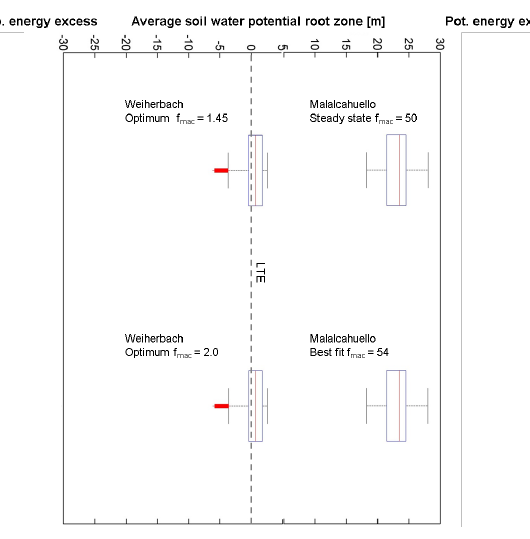
Fig. 13. Box plots of the soil water potentials for the two optima for the Weiherbach as well as steady-state macroporosity and the best fit model structure of the Malalcahuello catchment averaged across the top 1 meter of the soil (this corresponds to rooting depth in the Weiherbach and to one third of the rooting depth in Malalcahuello). Average soil water potentials are 0.49 m for the first and 0.48 m for the second optimum in the Weiherbach catchment.